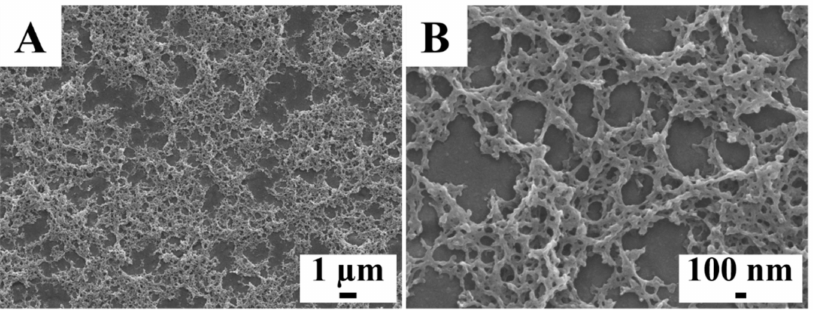
Figure 2. ( A , B ) SEM images at different magnifications of a coating fabricated using 10 g L − 1 solution of PMMA with R wip = 0.25.